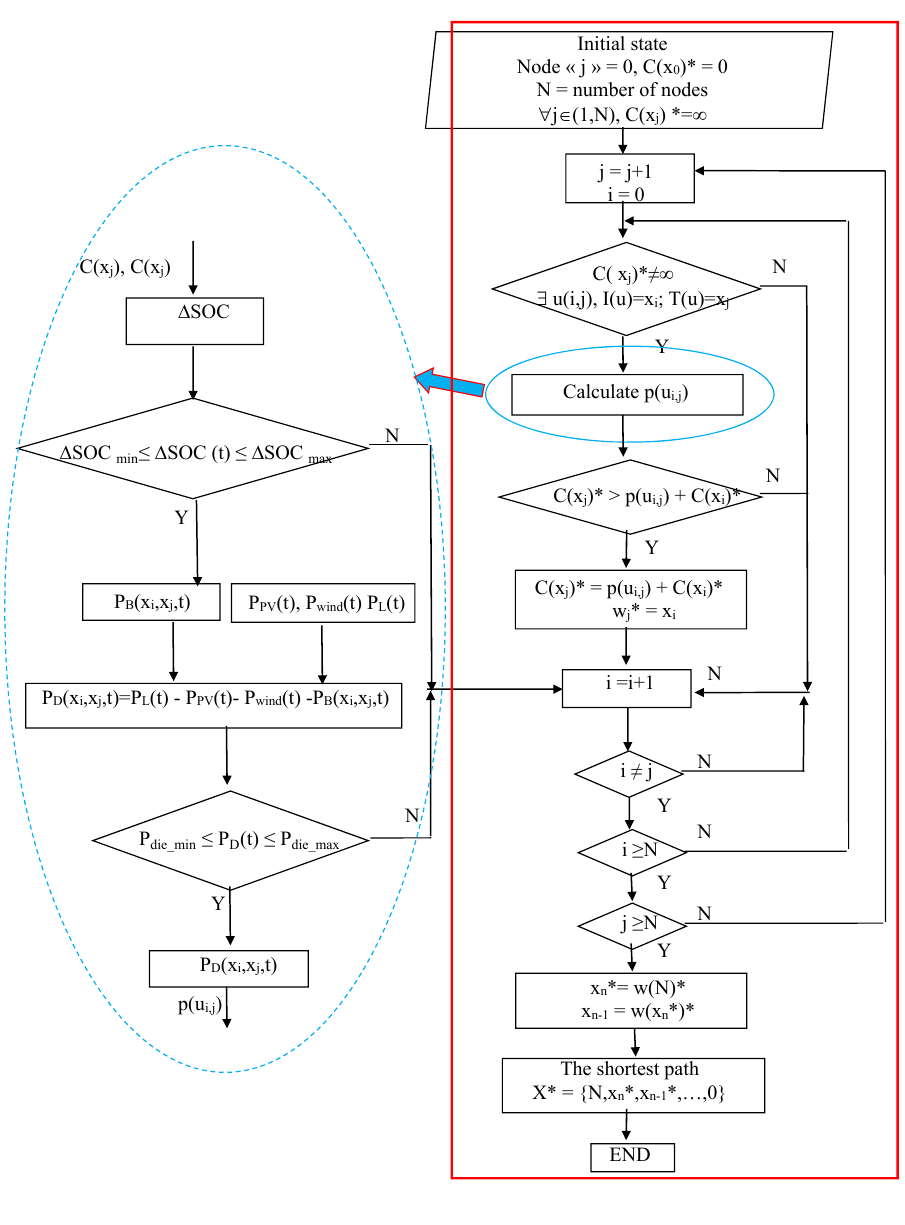
Figure 4. The flowchart of the proposed DP-based